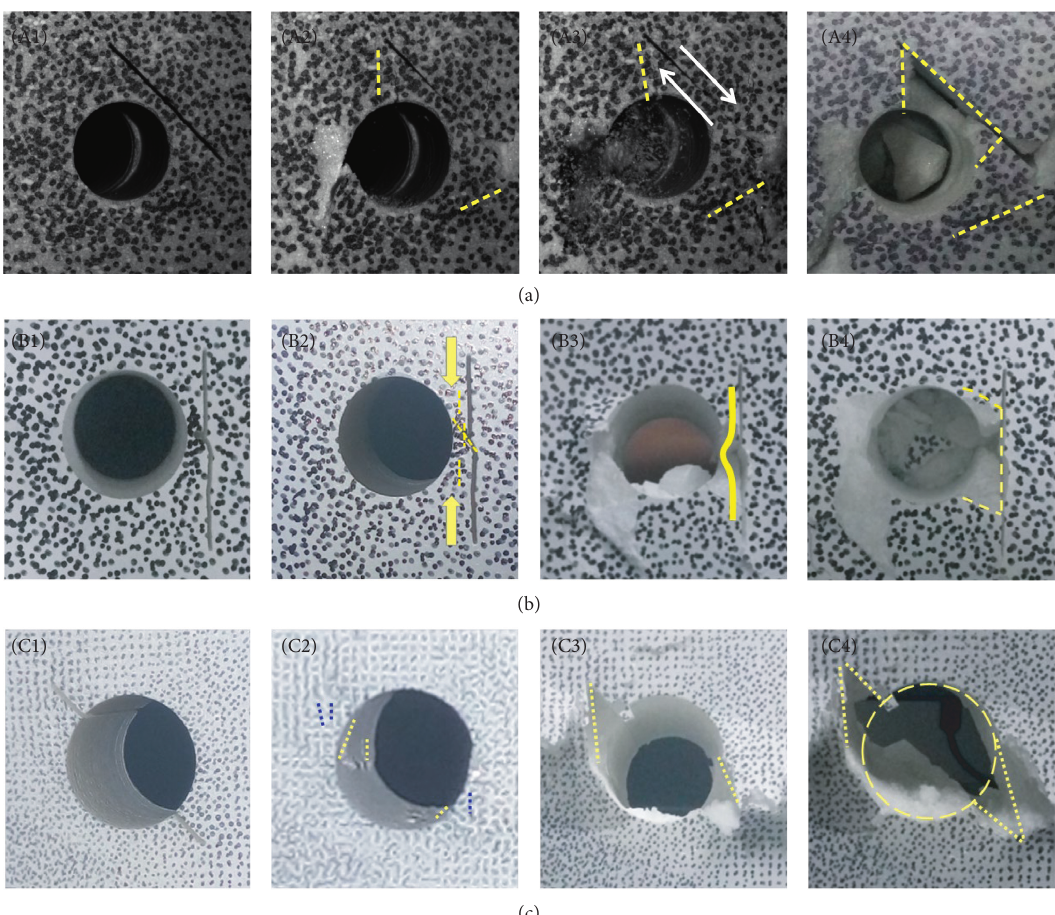
Figure 5: The rockburst evolution processes of three types of model samples: (a) fault-slip rockburst, (b) buckling rockburst, and (c) shear rupture